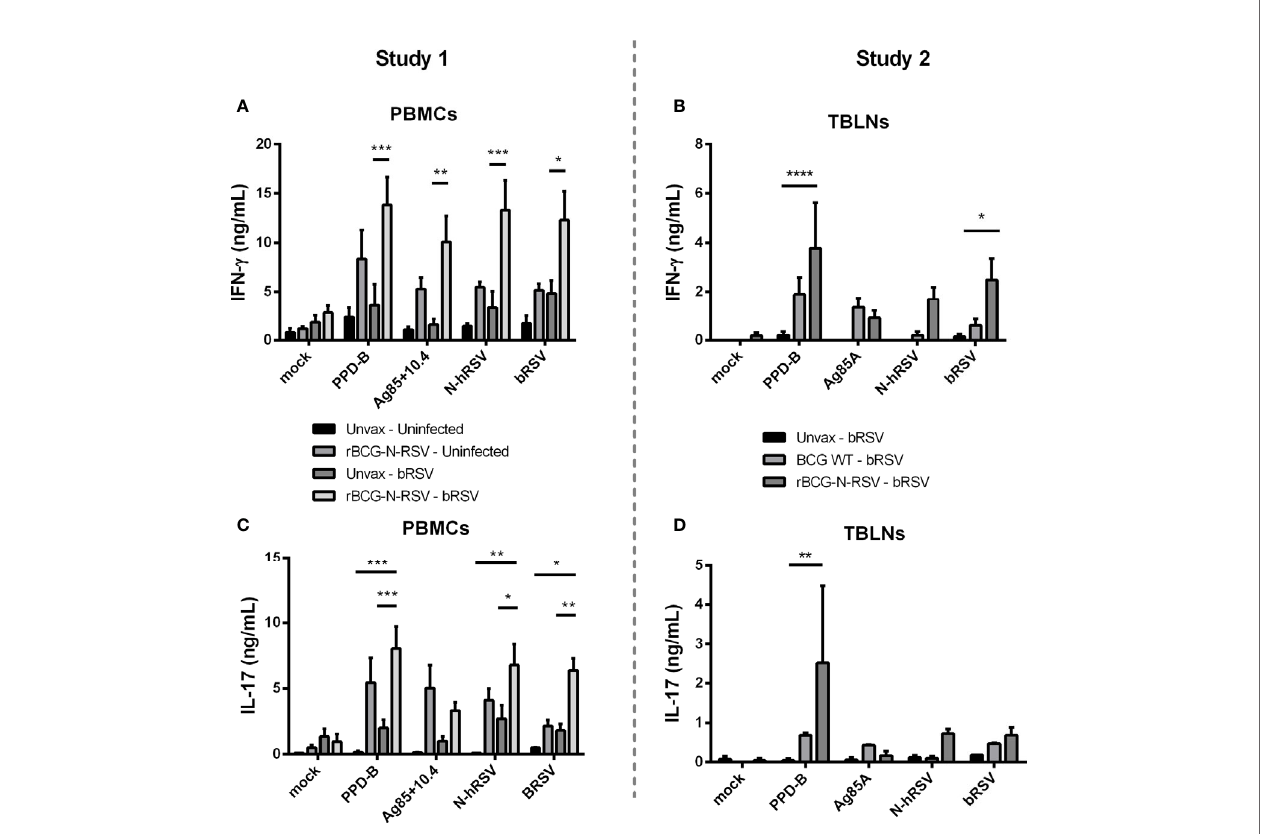
FIGURE 5 | Vaccination with rBCG-N-hRSV increases virus and BCG-speci fi c IFN- g and IL-17 secretion in PBMC cultures. (A, C) Study 1 PBMCs and (B, D) Study 2 Tracheobronchial lymph node cells (TBLNs) were isolated on day 7 post-infection, labeled with Cell Trace Violet, and restimulated in vitro with PPD-B, Ag85A/TB10.4, N-hRSV or bRSV strain 375. Mock stimulated cultures were used as negative controls. ConA stimulated cultures were used as positive controls (not shown). Six days later, cell culture supernatants were analyzed for bovine IFN- g and IL-17A secretion using commercial ELISA kits. *p < 0.05 **p < 0.01 ***p < 0.001 ****p < 0.0001 as determined by Two-way ANOVA and Sidak ’ s multiple comparisons test. Data represented as mean ±